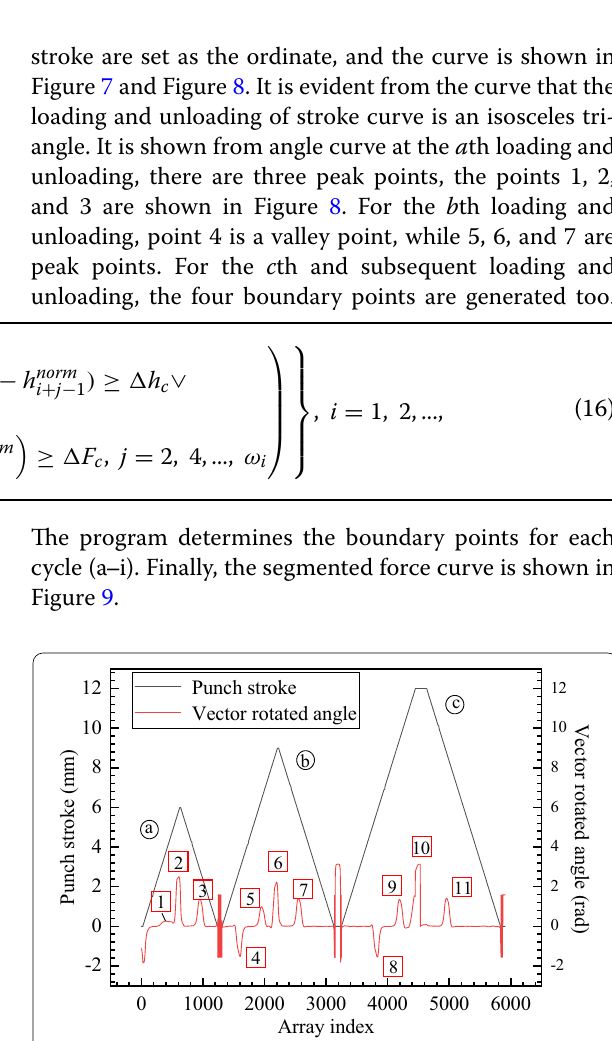
Figure 8 Enlarged view of loading and unloading force curve and